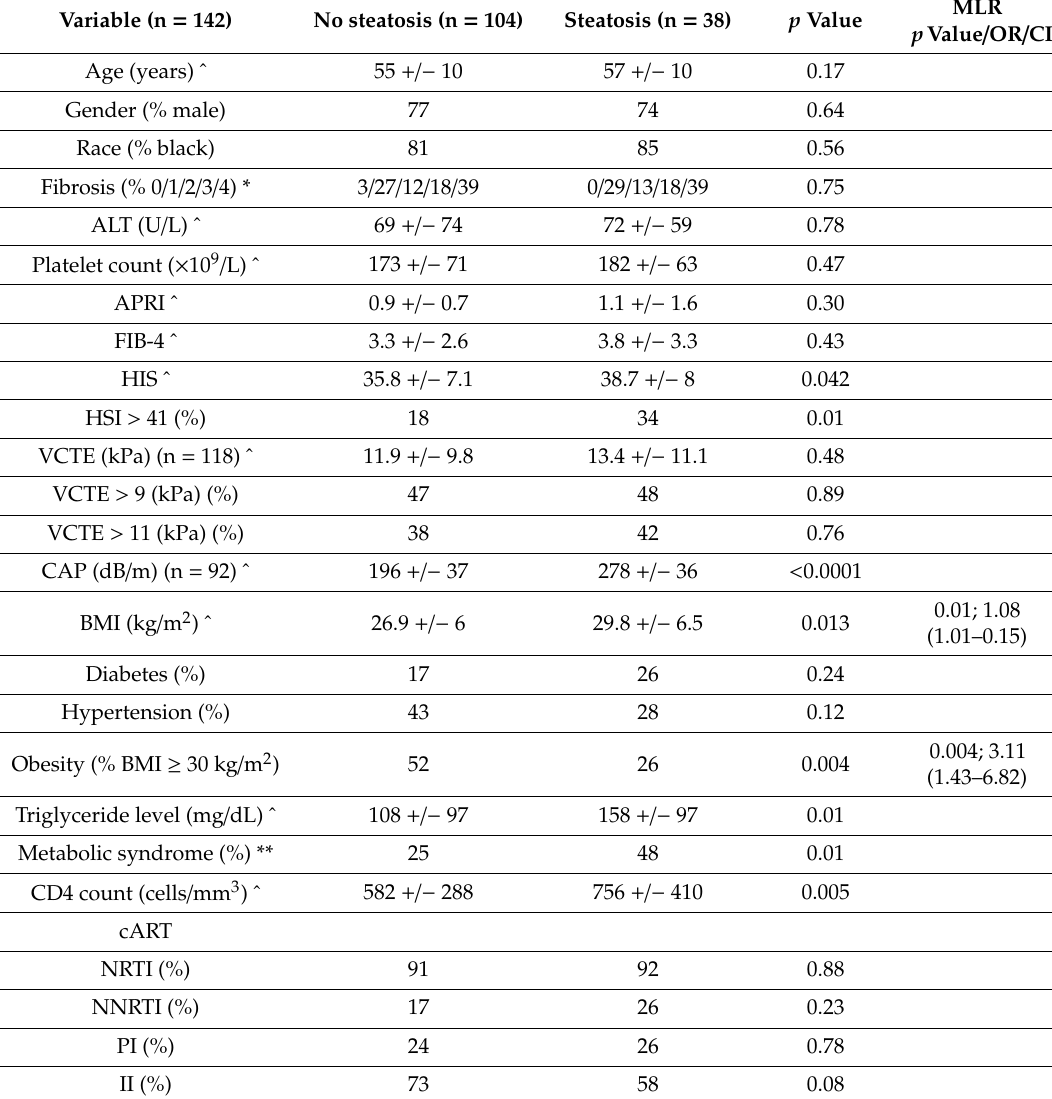
Table 3. Demographic, laboratory and liver disease characteristics of the cohort by the presence or absence of